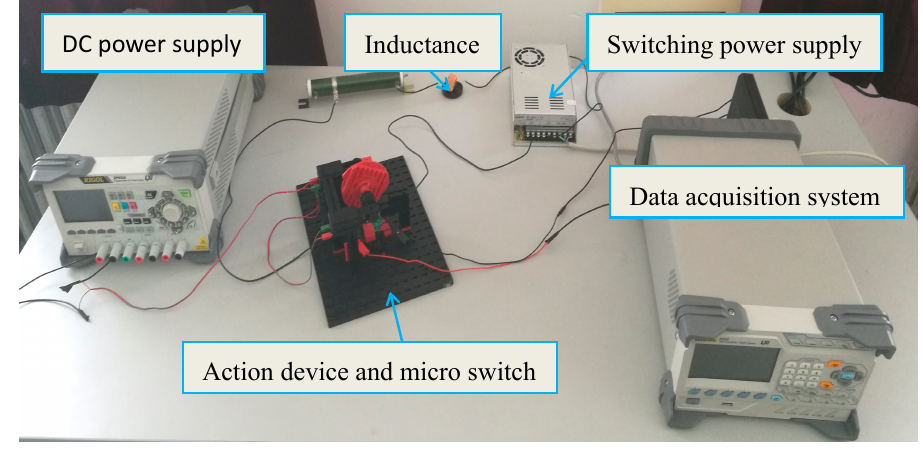
Figure 3. The test rig of micro-switches.